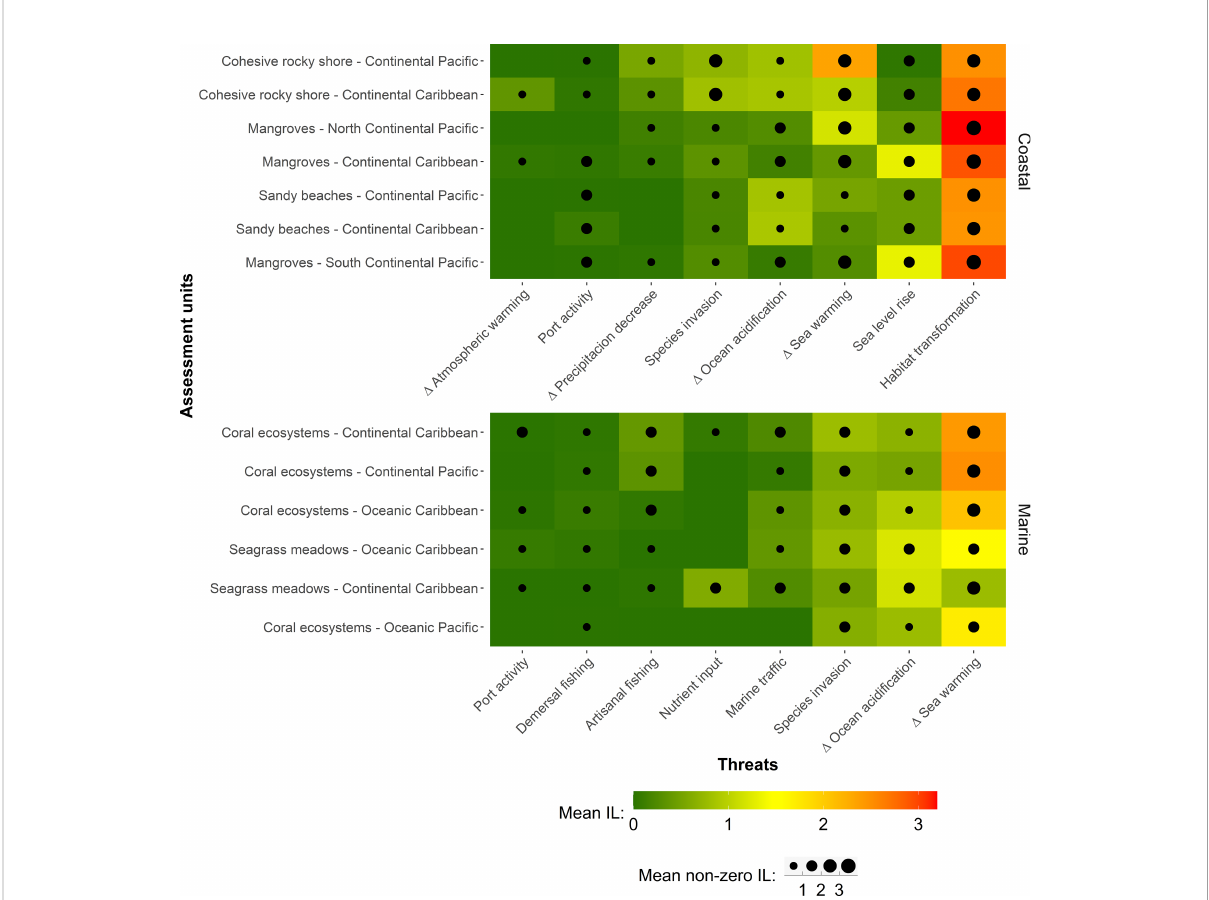
FIGURE 6 Level of impact by ecosystems and pressures. Threats with D labels indicate change over time. The continuous scale of the graph can also be interpreted categorically, where green, yellow, and red denote low, intermediate, and high impacts,